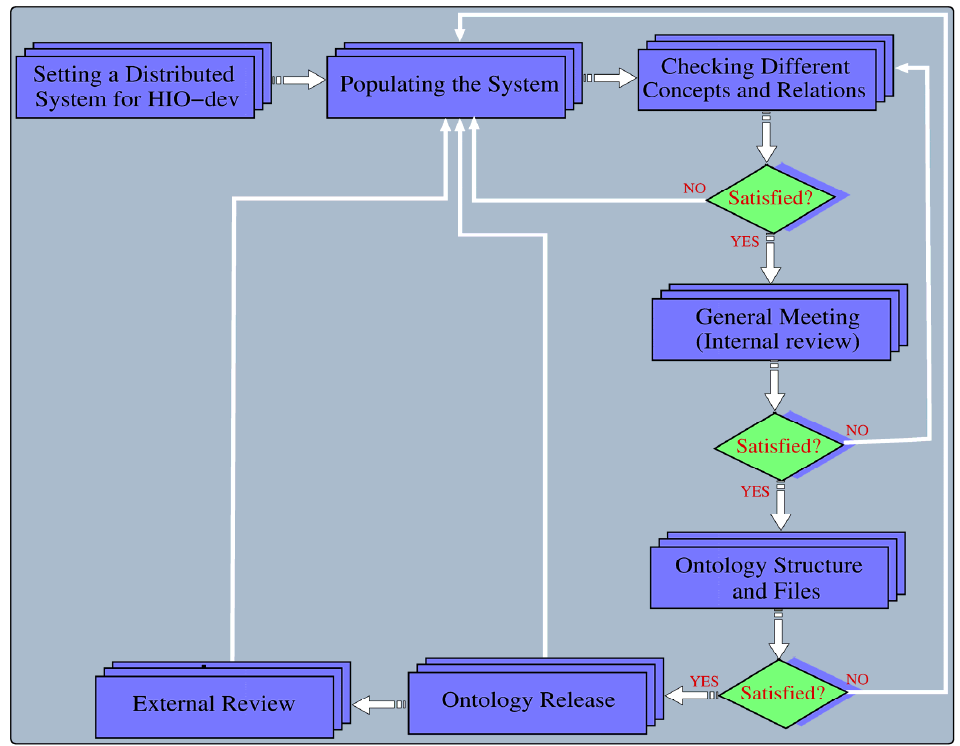
Figure 1. Flow chart of the dynamic and iterative ontology development process. It starts by setting